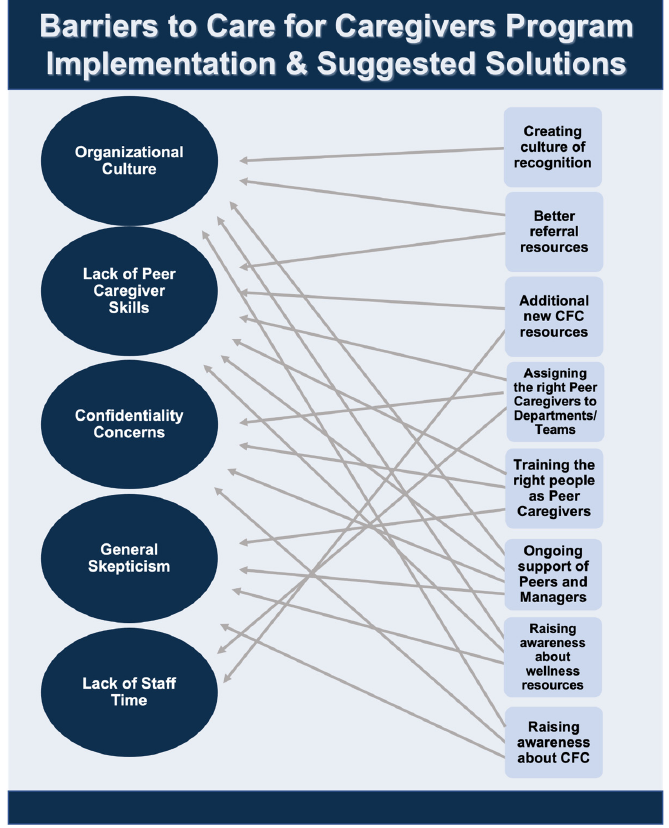
Figure 3. Barriers to the Care for Caregivers program implementation and suggested solutions from participants . from